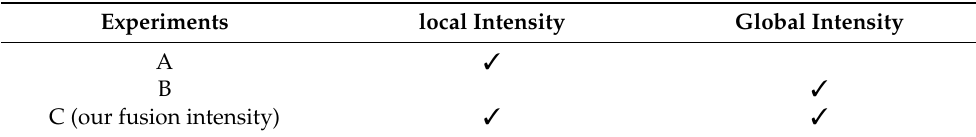
Table 2. The comparative experiment of the local-global intensity.